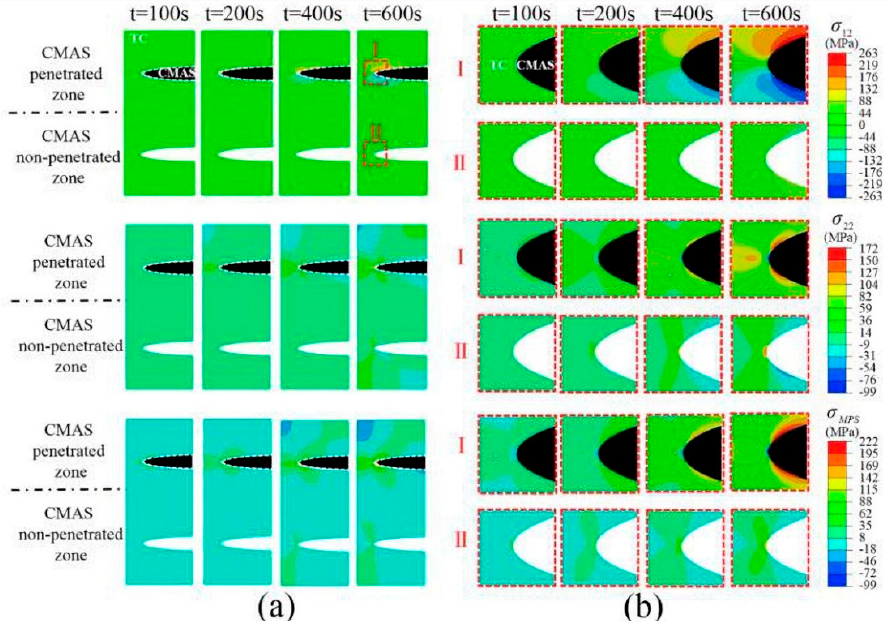
Figure 12. ( a ) Distribution of shear stress σ 12 , stress in the y -axis direction σ 22 , and max in-plane principal stress σ MPS around the microstructure with and without CMAS at di ff erent cooling times, ( b ) magnification of zone I with CMAS and zone II without CMAS shown in ( a ). Reprinted with permission from [84]; Copyright 2019 Elsevier.